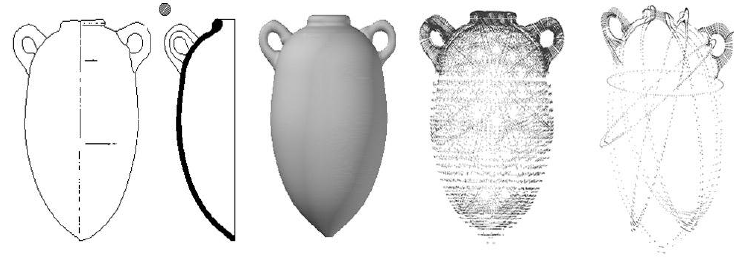
Figure 15. From left to right; the amphora model designed by the archaeologist, then the 3D model computed from the archaeological design. Two illustrations of level curves extraction using several planes.